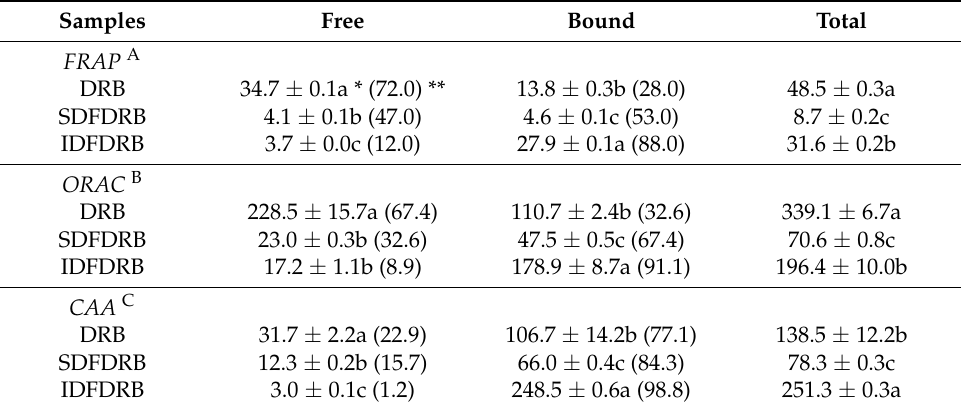
Table 3. Antioxidant activities of defatted rice bran and its dietary fibres. Samples